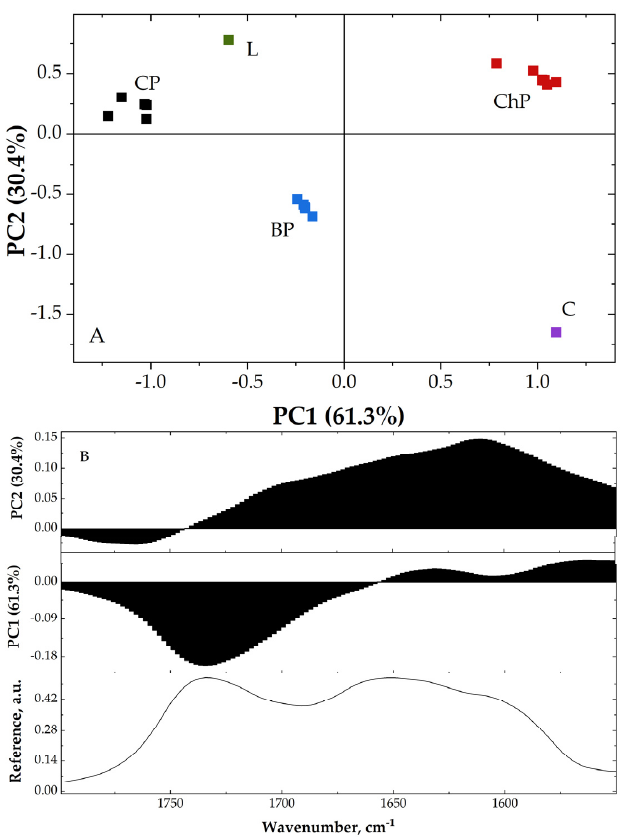
Figure 3. PC scores plot ( A ) and loadings plot ( B ); L—lignin, C—cellulose, CP—contemporary